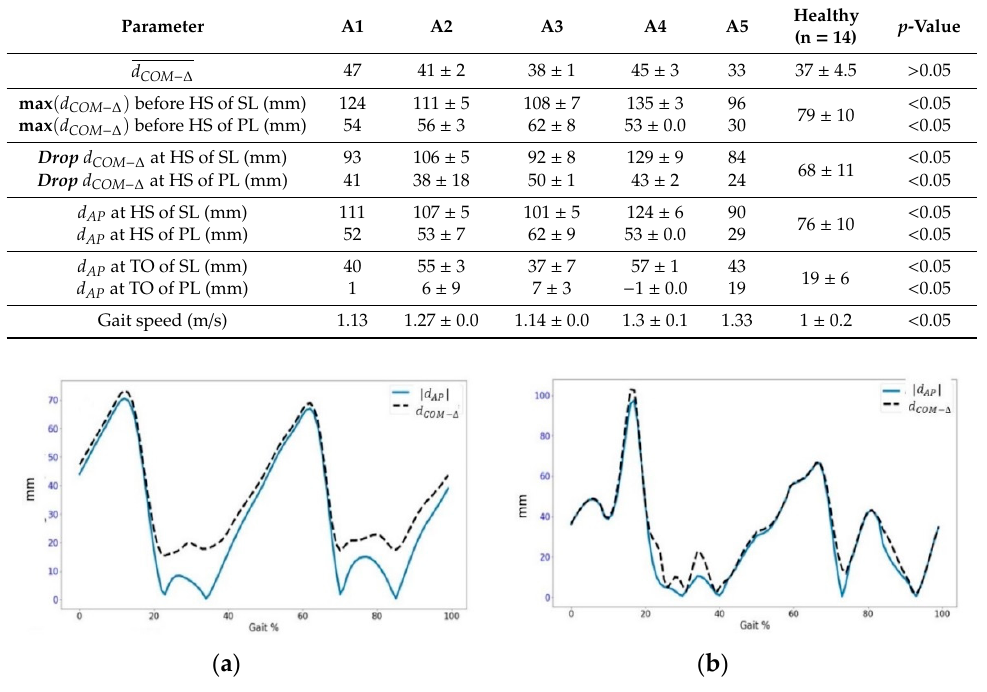
Figure 4. Evolution of the norm of the distance between minimal moment axis and COM ( d COM − ∆ ) dashed line and the absolute value of the anterior-posterior component ( d AP ) full-line, during the gait cycle, for the average of healthy subjects ( a ) and one person with amputation ( b ).